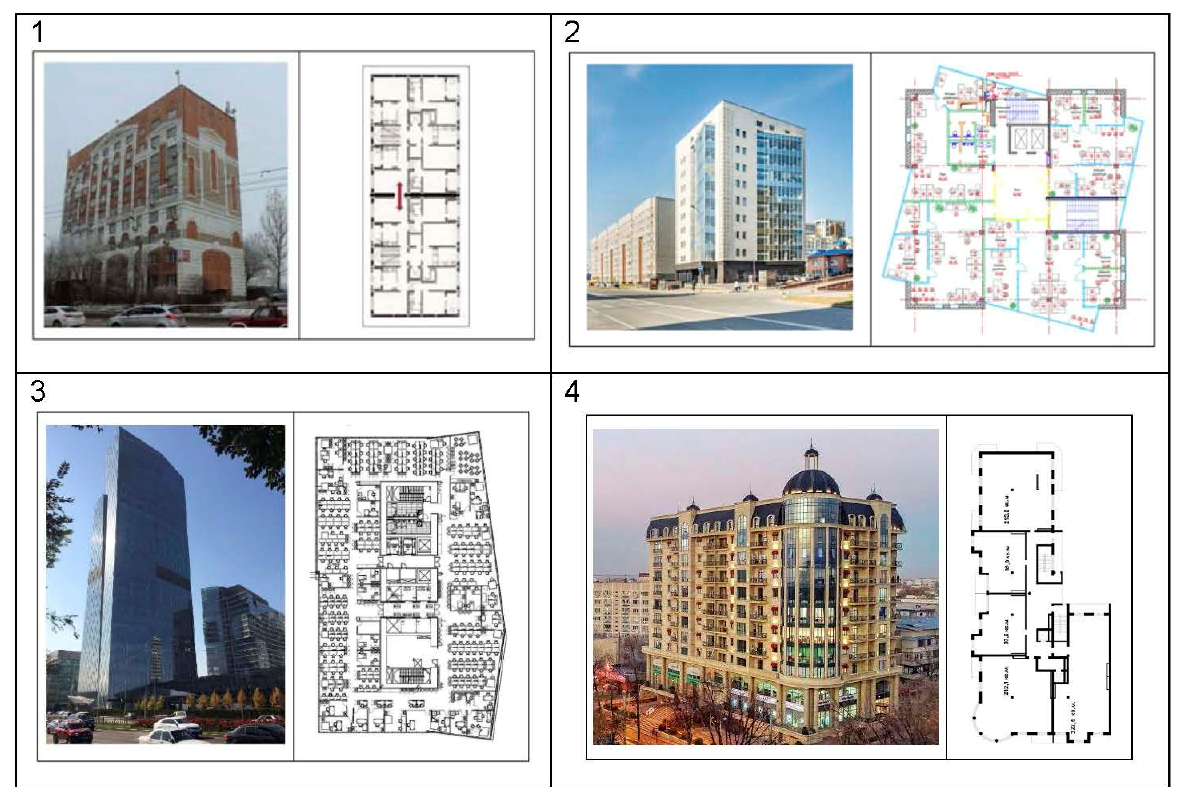
Figure 7. Kazakhstan’s business centers of the late 20th to the early 21st century: ( 1 ) The ALMATY HOUSE-BUILDING PLANT, Almaty, 1985 [96]; ( 2 ) The SEVEN, Astana, 2020 [97]; ( 3 ) The ESENTAI TOWER, Almaty, 2008 [98]; and ( 4 ) The ALMATY RESIDENCE, Almaty, 2014 [99].